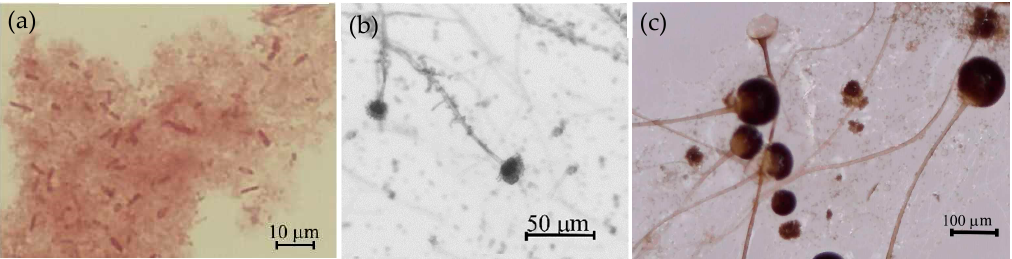
Figure 2. Microbial species seen by optical microscopy (magnification 400× for bacteria and 40× for fungi): ( a ) P. putida, ( b ) A. fumigatus , ( c ) Rh. oryzae .